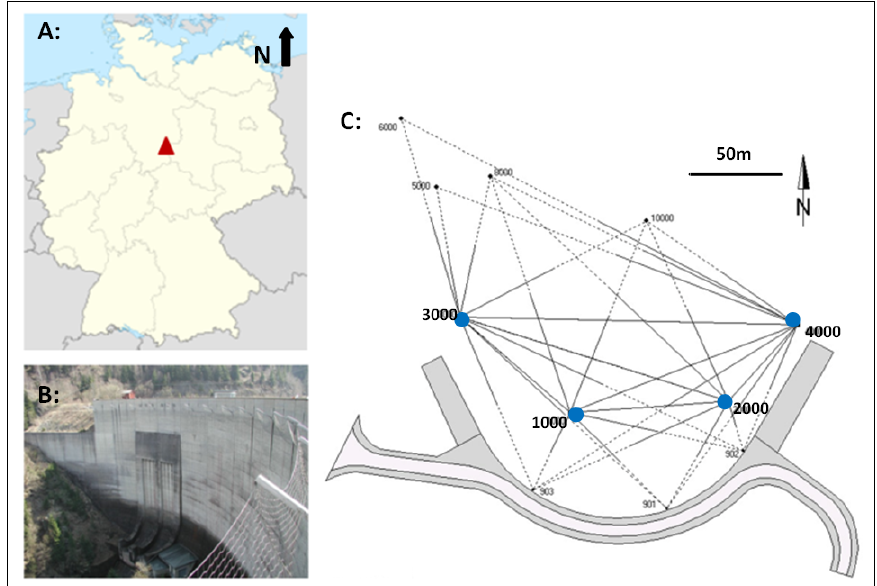
the dam. ( B ) Photograph of the Oker dam surface. ( C ) Geodetic monitoring network of the Oker dam [14] (top view). The blue points are the scan